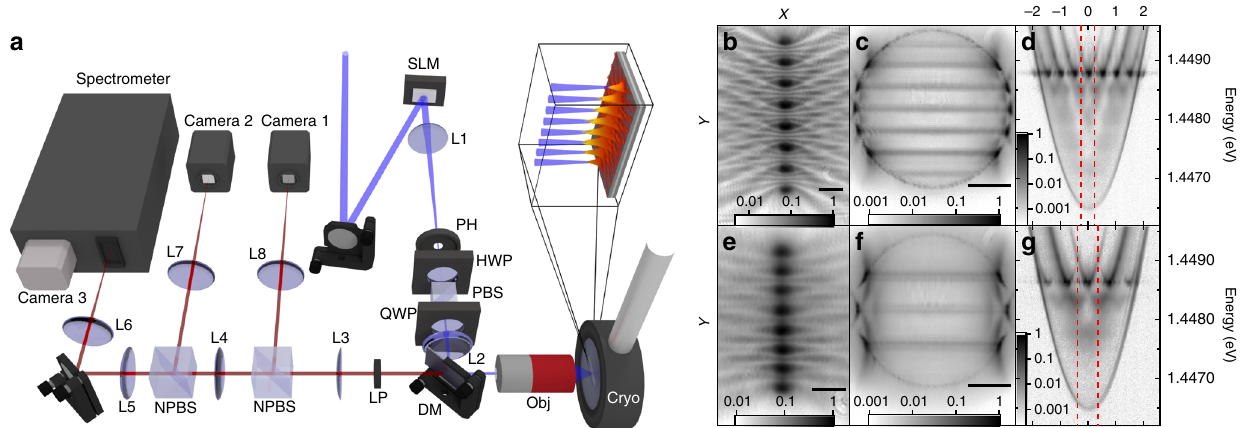
Fig. 1 Experimental polariton condensate photoluminescence using eight non-resonant pump spots forming chains with uniform inter-condensate separation distances. a Schematic representation of an experimental system where the blue beams represent the blue detuned non-resonant excitation laser and the red beams represent the photoluminescence. In the schematic: SLM spatial light modulator, PH pinhole, HWP half waveplate, QWP quarter waveplate, PBS polarising beam splitter, NPBS non-polarising beam splitter, DM dichroic mirror, obj microscope objective lens, cryo cold fi nger fl ow cryostat, LP long pass fi lter and L1 – L8 planoconvex lenses. The inset of the schematic (top right) shows a zoomed in region of the sample at the focus of the sculpted non-resonant pump beam along with the resulting polariton distribution corresponding to b . b – g Logarithmic colourmaps showing the polariton condensate ( b , e ) real-space and ( c , f ) k -space distributions, and ( d , g ) the corresponding dispersions. The lattice constant is approximately 13 μ m in b – d and approximately 8.6 μ m in e – g . The black lines on the bottom right of b , e represent 15 μ m and in c , f represent 1 μ m − 1 scale bars. The red vertical dashed lines in d , g symbolise the boundaries of the reduced Brillouin zone of the polariton crystal.